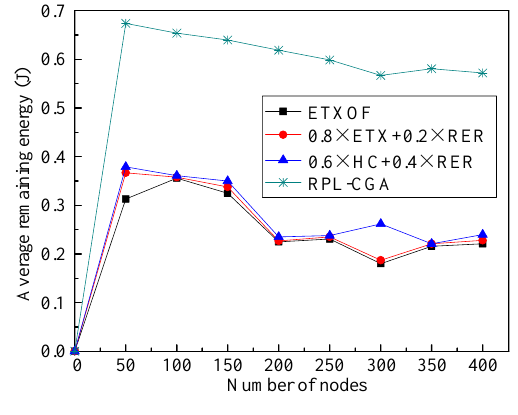
Figure 5. Average remaining energy.